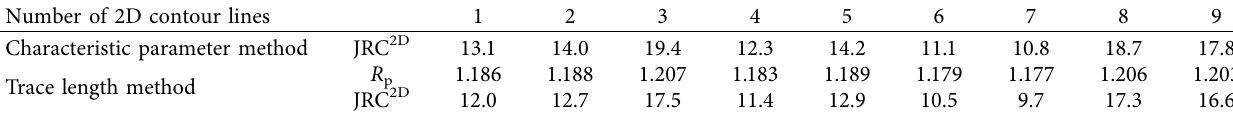
Table 4: Roughness evaluation of form line based on trace length